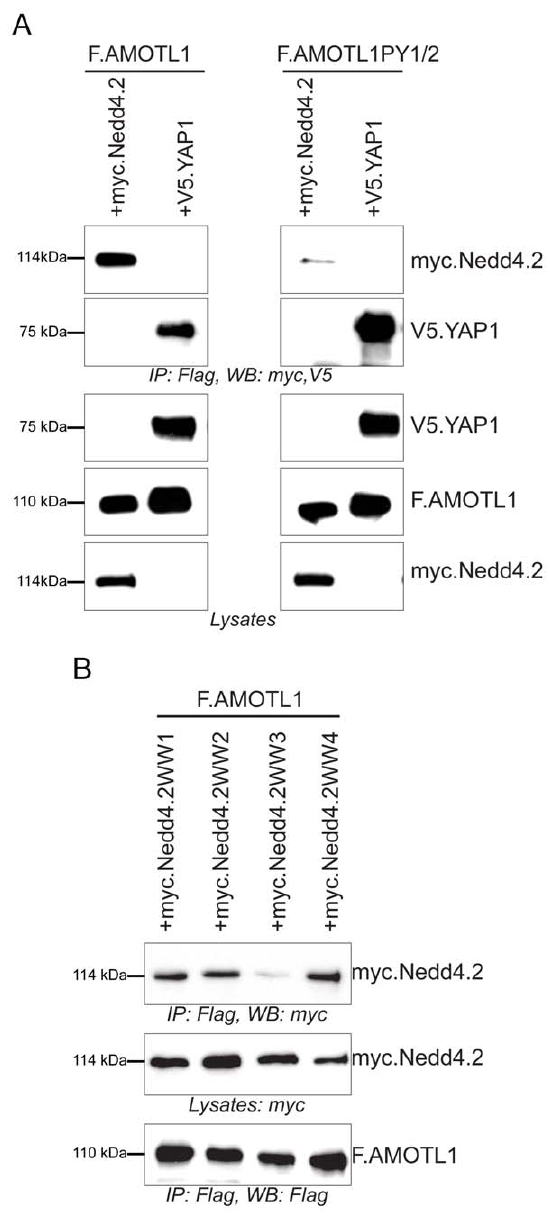
Figure 2. The WW3 domain of Nedd4.2 interacts with AMOTL1. A , The two PPxY motifs of AMOTL1 (PY1: PPEY, amino acid 310–313, and PY2: PPEY, amino acid 367–370) are important for the interaction with Nedd4.2. Precipitation of wild type F.AMOTL1 immobilized both